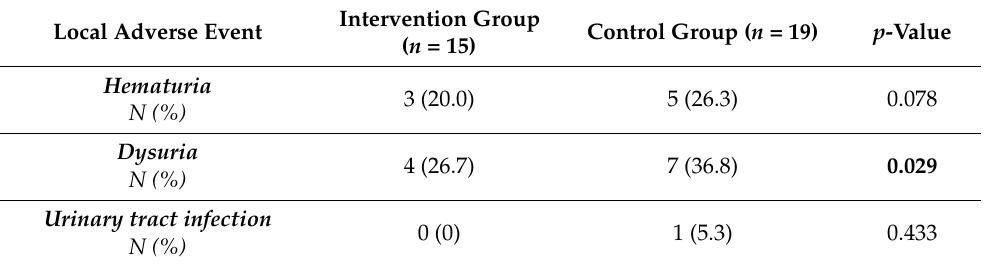
Table 5. Local side effects of intravesical